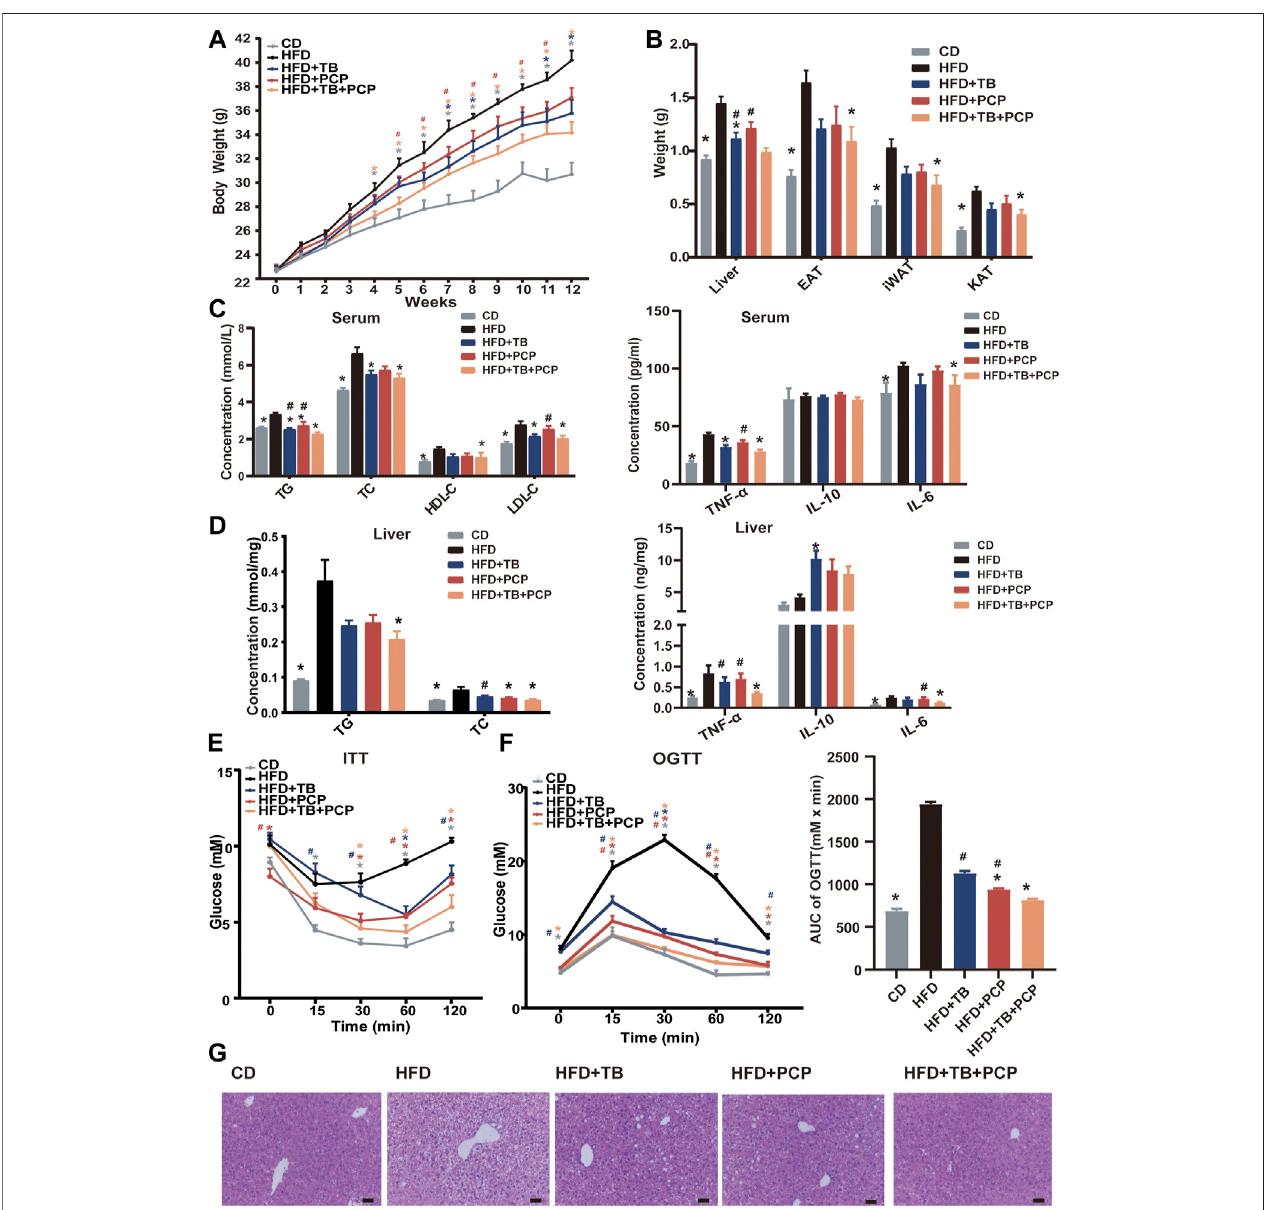
FIGURE 1 | The phenotypes of the mice in CD, HFD, HFD + TB, HFD + PCP, and HFD + TB + PCP groups. (A) The body weights across 12-weeks treatment. (B) The weights of liver, epididymal adipose tissue (EAT), perirenal adipose tissue (KAT), and subcutaneous inguinal white adipose tissue (iWAT). (C) The levels of serum lipids(TG,TC,HDL-C,LDL-C)andin fl ammatoryfactors. (D) ThehepaticTGandTClevelsandin fl ammatoryfactors. (E) ThebloodglucoselevelsofITT(baseline,and15, 30, 60, 120 min after insulin loading). (F) The blood glucose levels of OGTT (baseline, and 15, 30, 60, 120 min after insulin loading) and the AUC of OGTT. (G) Representative images of liver HE staining. Scale bars, 50 μ m. 100× magni fi cation. Data were expressed as mean ± SEM. Differences between groups (all groups comparedtotheHFD group)wereassessed usingtheone-wayANOVAtest;* p < 0.05compared withtheHFDgroup. Differencesbetweengroups(HFD+TBandHFD + PCP compared to the HFD + TB + PCP group) were assessed using the one-way ANOVA test; # < 0.05 compared with the HFD + TB + PCP group.